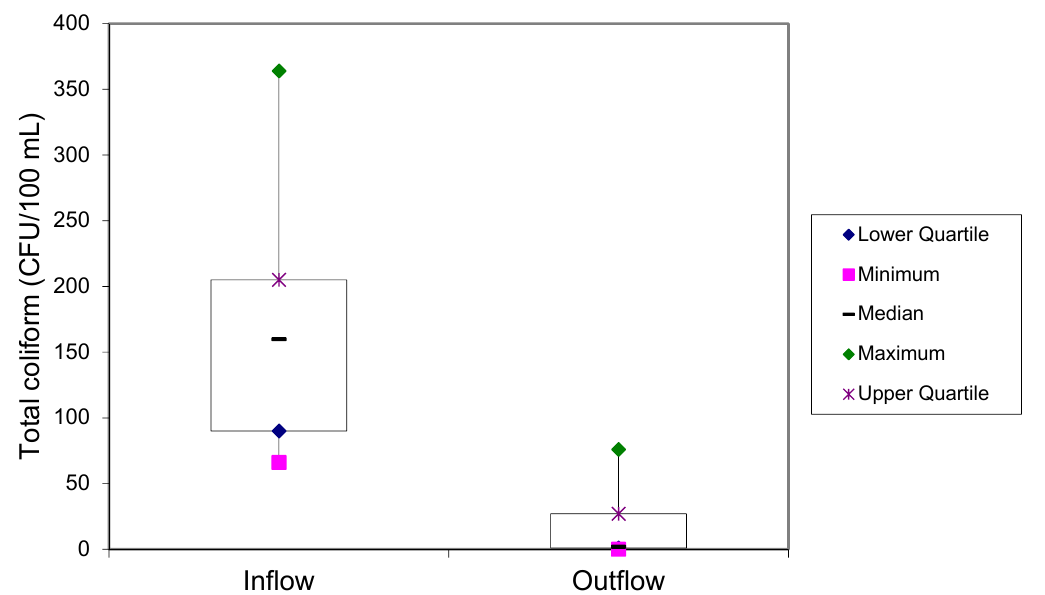
Figure 5. Box and whisker plot highlighting differences of inflow (n = 390) and outflow (n = 390) total coliform count for the silver nitrate filters.